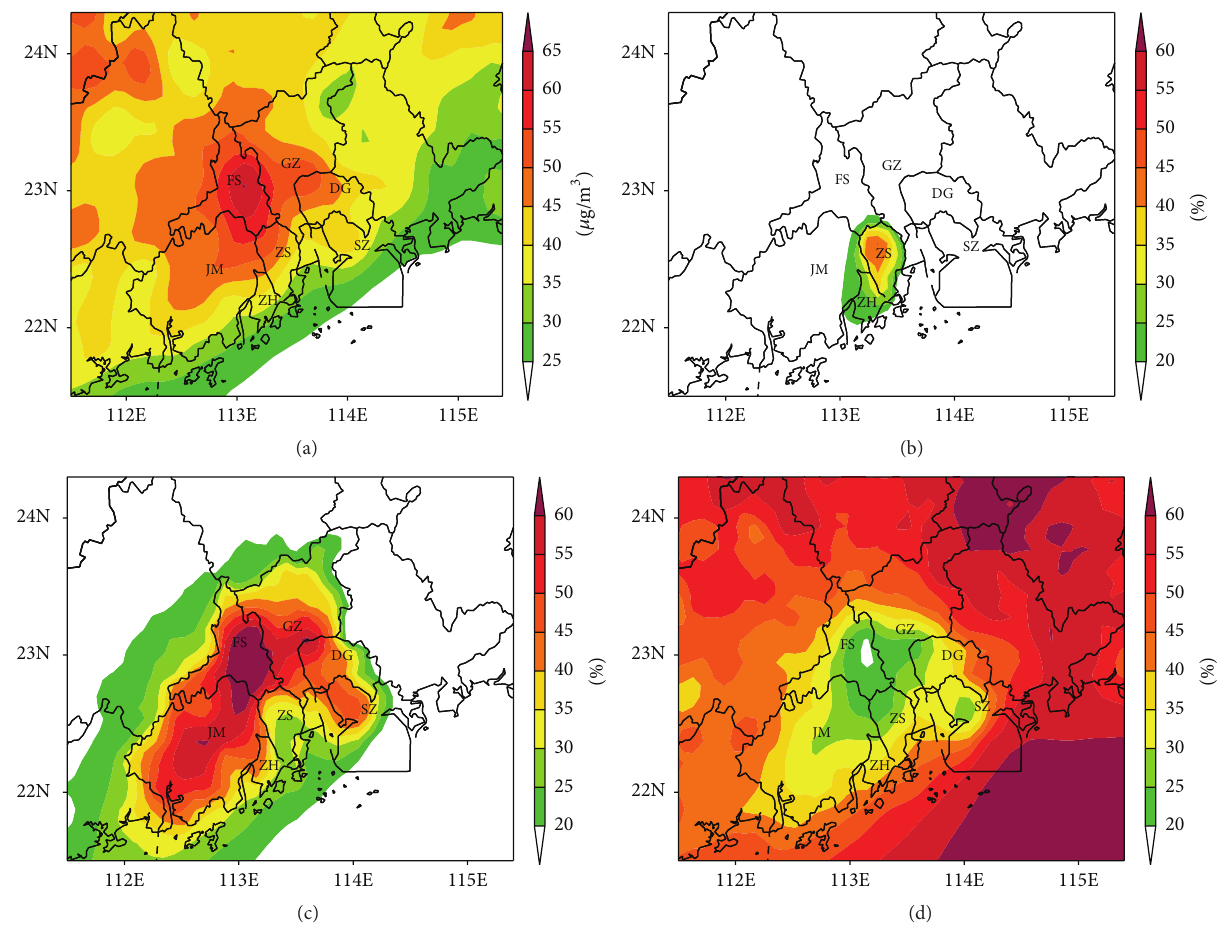
Figure 5: (a) Spatial distribution of simulated monthly mean PM 2.5 concentrations, (b) percentage contributions of local emissions in Zhongshan, (c) percentage contributions of emissions from other cities in the PRD, and (d) percentage contributions of emissions from outside of Guangdong Province.